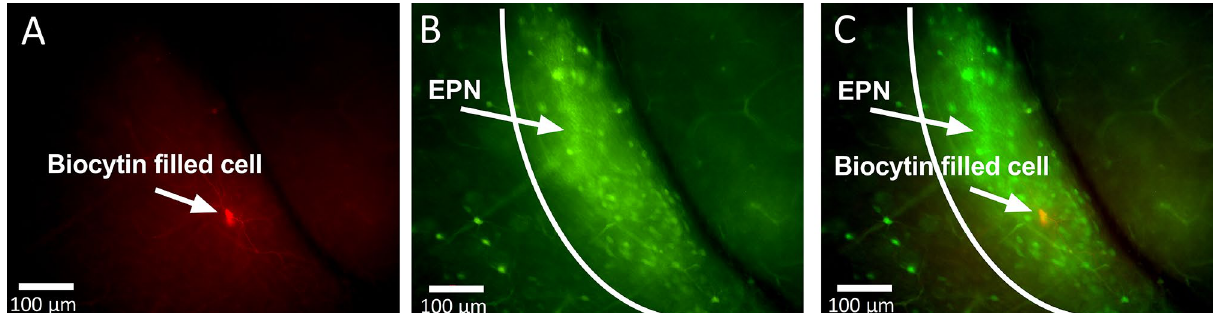
Figure 3. OXTR-EGFP expressing neurons in the endopiriform nucleus (EPN). During initial electrophysiological recordings, biocytin was added to the intracellular solution and injected into the recorded cell. Post-labelling of these cells ( A ) revealed anatomical location of neurons recorded from during electrophysiological experiments. Endogenous expression in the OXTR-EGFP mouse tissue slice (300 µm) shows dense OXTR-EGFP expression in the EPN ( B ). The combined image ( C ) shows that the location of the cell recorded from was the OXTR-EGFP rich was fast (4 min, similar to TTX effect) or slow/prolonged (6 min). In EPN neurons held just above threshold by injecting positive current in current clamp recordings, there was a significant effect of bath application of oxytocin (200 nM) (One-way repeated measures (RM) ANOVA F (2.112, 10.56) = 6.315, p = 0.015, n = 6 cells, 3 animals-1 male/2 female). Post hoc comparisons using the Dunnett’s multiple comparisons test (MCT) showed that EPN neurons exhibited more spontaneous action potentials at 4 min into OXT bath application compared to baseline levels (M∆ = 32.83, SE 6.779, Q = 4.843, df = 5, p = 0.011, d = 1.87, Fig. 4A, Supplementary Table 1 Line A). The number of spontaneous action potentials fired at 6 min was not significantly different from baseline and the cells returned to baseline levels of spontaneous firing after 20 min of washout with aCSF (M∆ = -6.667, SE = 8.265, Q = 0.807, df = 5, p = 0.768). OXT not only binds to the OXTR which we have shown is present in the EPN, but it also binds to vasopres- sin receptors 47–51 so it is possible that the effect seen above was due to OXT binding at vasopressin receptors. To avoid binding at vasopressin receptors, the OXTR selective agonist TGOT was used for the remainder of the experiments 46 . Using the same experimental design as described above, an aCSF solution containing TGOT (200 nM) was bath applied to the tissue slice during whole-cell patch clamp electrophysiological recording of an EPN neuron held just above threshold in current clamp and the number of spontaneous action potentials was quantified before, during and after TGOT application. One-way RM ANOVA indicated a significant effect of TGOT (F (1.483, 10.38) = 8.918 p = 0.008, n = 8, 2 animals-1 male/1 female) with EPN cells firing a significantly greater number of action potentials at 4 min into the bath application of TGOT (M∆ = 20.13, SE = 6.26, Q = 3.215, df = 7, p = 0.036, d = 1.25) and exhibited significantly fewer spontaneous action potentials than baseline after 20 min of aCSF washout (M∆ = -8.75, SE = 2.22, Q = 3.94, df = 7, p = 0.014, d = 1.35. Figure 4B,C, Supplementary Table 1 Line B). To further characterize the effect of TGOT on EPN neurons at the resting membrane potential (RMP), a separate experiment was performed at the cells RMP with a three second positive current injection experimen- tally determined for each cell such that the current evoked between 2 and 10 action potentials during this time (n = 11, 4 animals-2 male/2 female). One-way RM ANOVA indicated a significant effect of TGOT bath applica- tion on the EPN cells RMP (F (2.486, 24.86) = 6.165, P = 0.006) with a significantly depolarized RMP at both 4 (Dunnett MCT, M∆ = 2.35 mV, SE = 0.699, Q = 3.362, df = 10, p = 0.019, d = 0.275) and 6 min (Dunnett MCT,